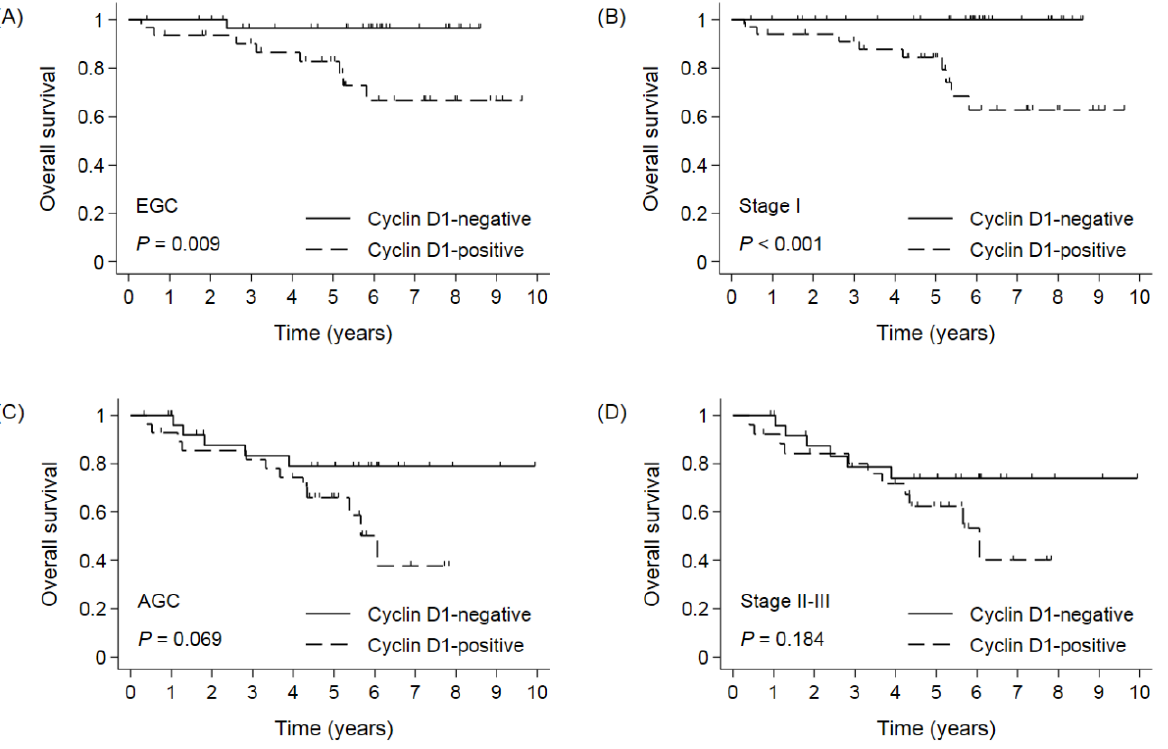
Figure 7. Forest plot for subgroup analyses of overall survival by cyclin D1 positivity in propensity score-matched cohort.